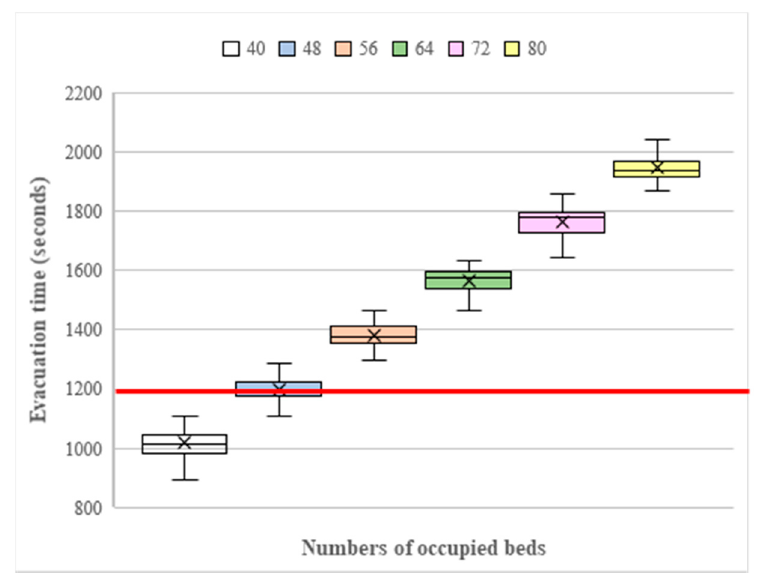
Figure 10. The evacuation times for different numbers of beds occupied without additional resources.